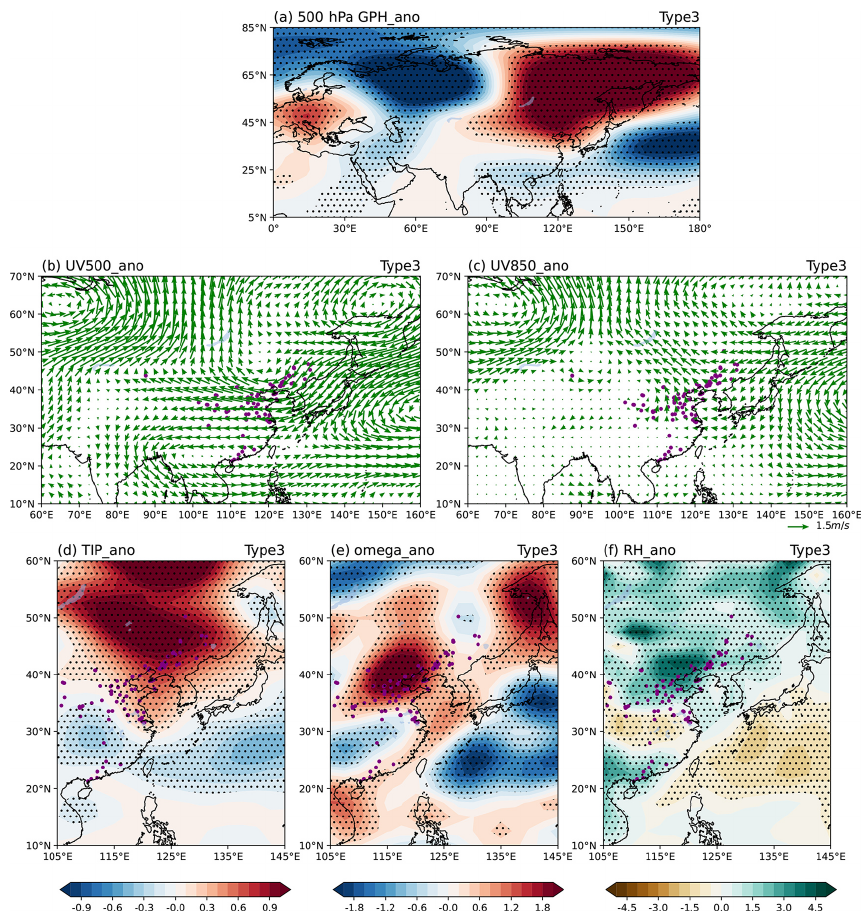
Figure 9. Composite anomalies of (a) GPH at 500hPa (unit: gpm), horizontal wind (unit: ms − 1 ) at (b) 500hPa and (c) 850hPa, (d) TIP (unit: K), (e) omega (unit: 10 − 2 Pas − 1 ), and (f) RH (unit: %) for circulation Type3. Dotted areas are statistically significant at the 95% confidence